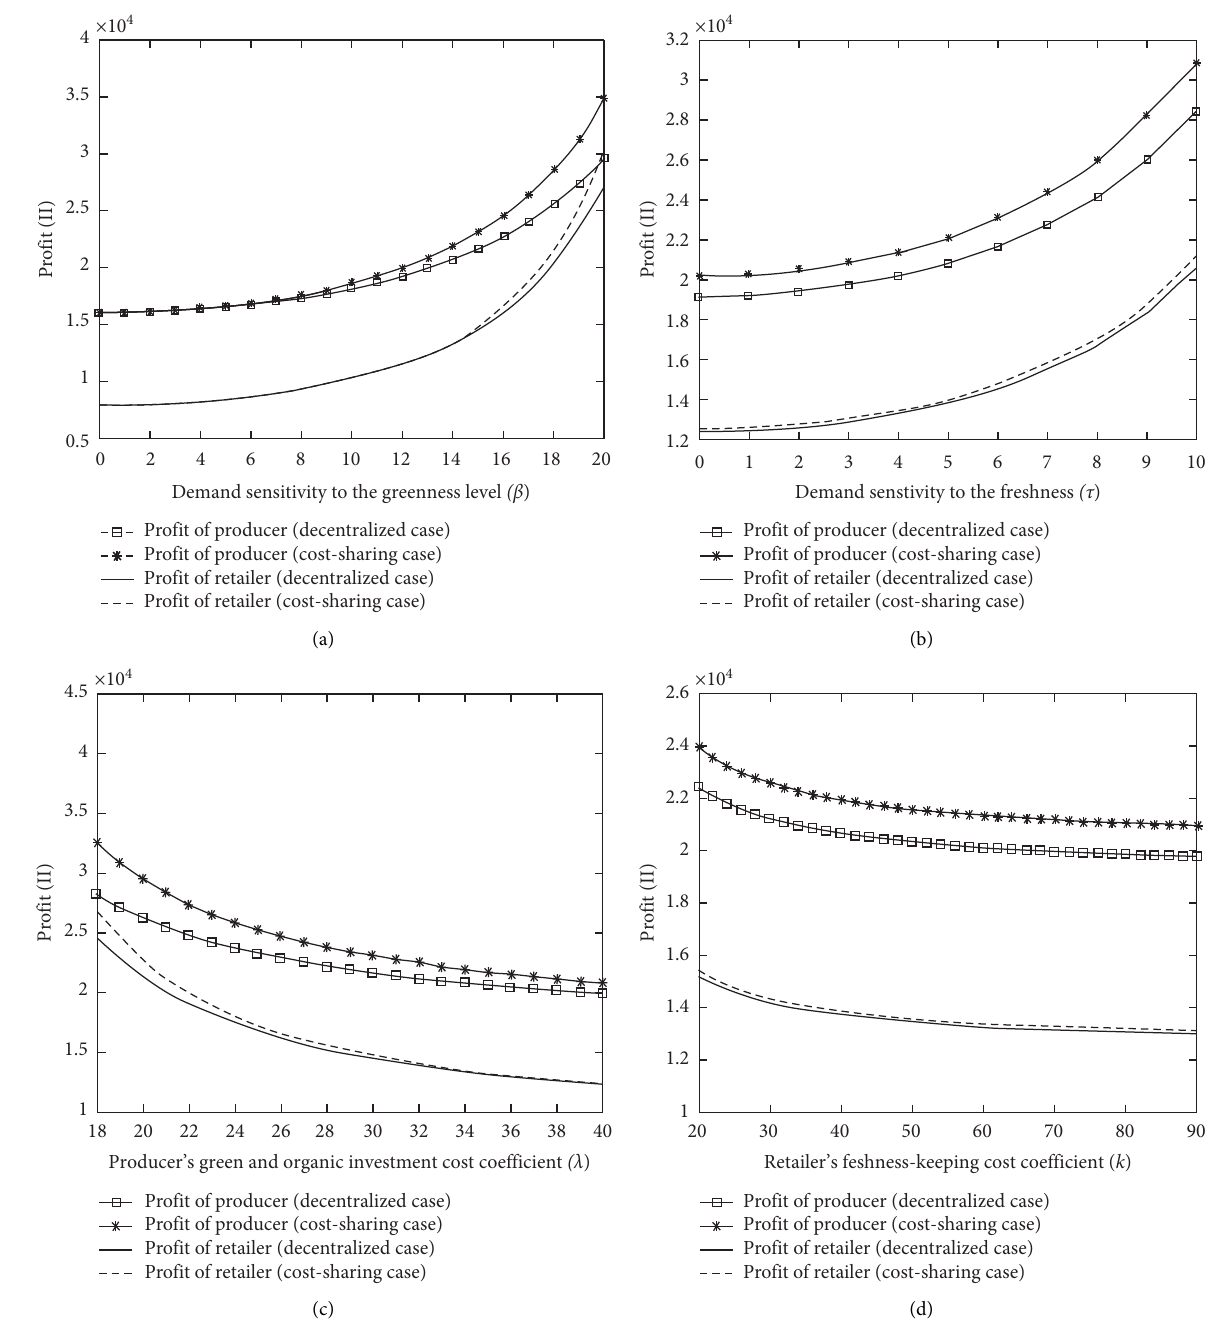
Figure 2: Impact of key parameters on individual profits in the APSC under different decision cases. (a) Individual profits vs. β . (b) Individual profits vs. τ . (c) Individual profits vs. λ . (d) Individual profits vs. k